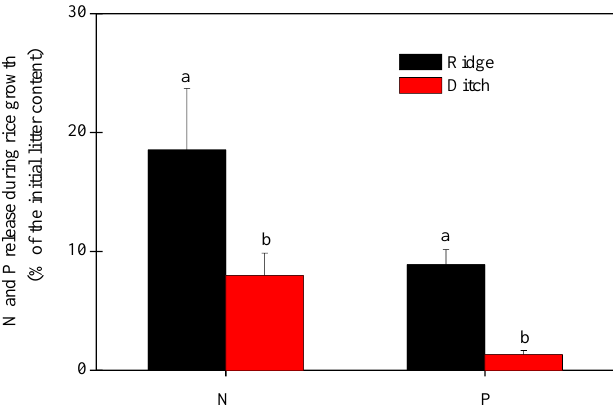
Figure 4. Comparison of nitrogen (N) and phosphorus (P) release during rice growth. Different letters mean statistical differences ( p < 0.05) of the corresponding variables between ridges and